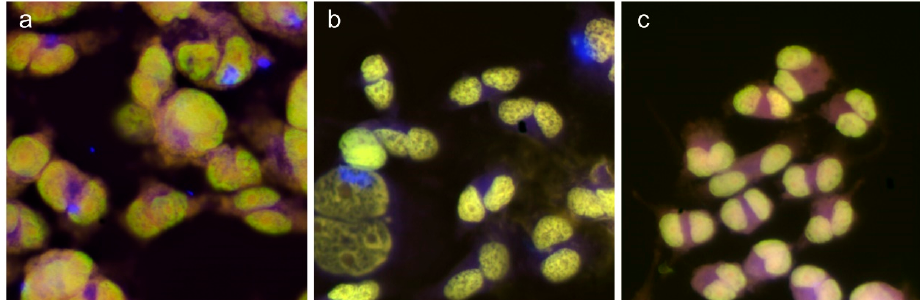
Figure 3. Examples of calcofluor staining (blue) in cells treated with U-NFC (167 µg/mL) ( a ), H-NFC (56 µg/mL) ( b ) and untreated cells ( c ). Counterstaining by acridine orange.